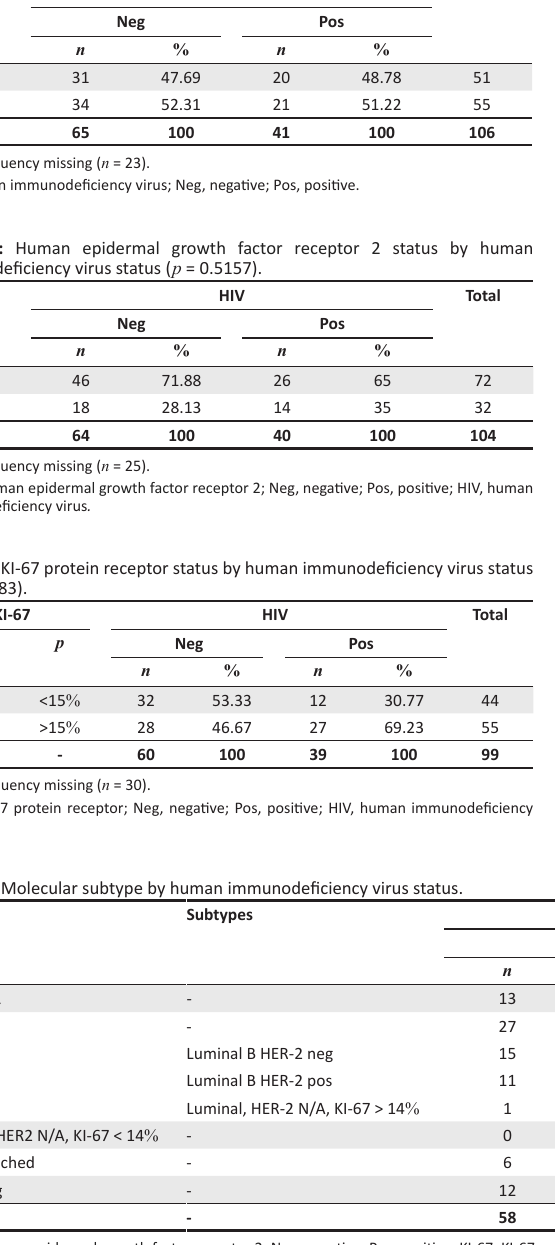
TABLE 2: Progesterone receptor status by human immunodeficiency virus status ( p = 1.00). Progesterone